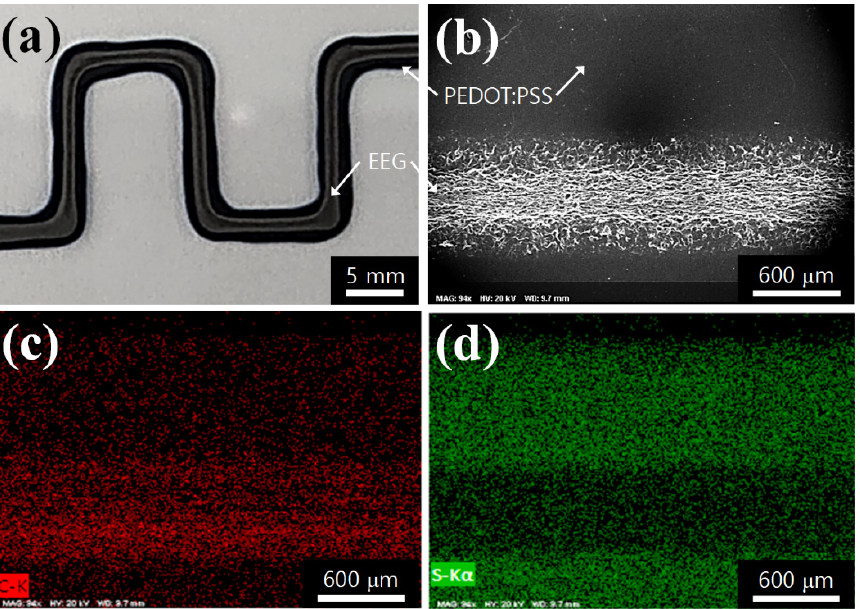
Figure 3. ( a ) Photo and ( b ) SEM images of the consecutive ink written-PEDOT:PSS/EEG electrodes on the glass substrate. ( c ) Carbon and ( d ) sulfur EDS mapping images. on the glass substrate. ( c ) Carbon and ( d ) sulfur EDS mapping